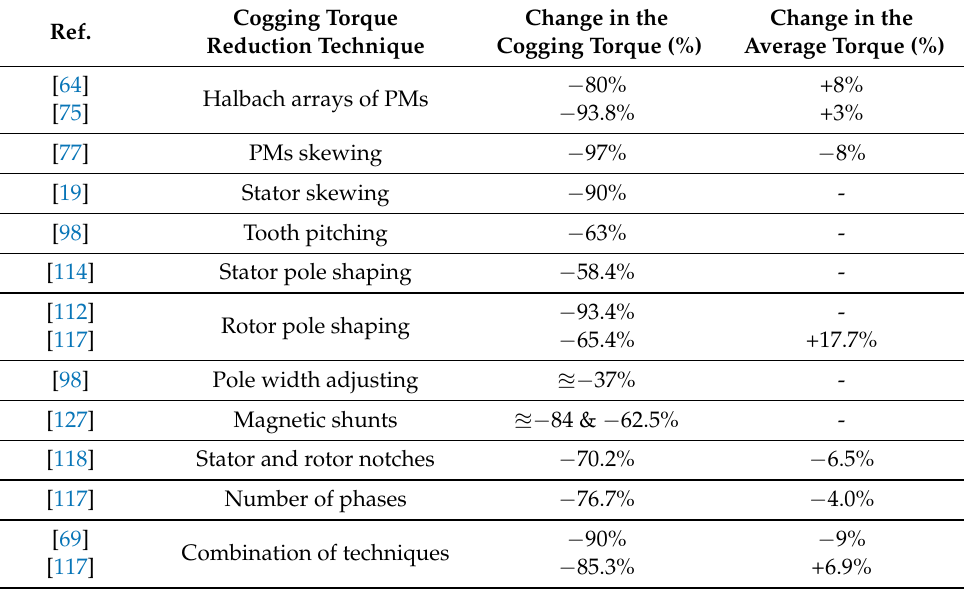
Table 4. Cogging torque and average torque changes reported in the literature after using a cogging torque reduction